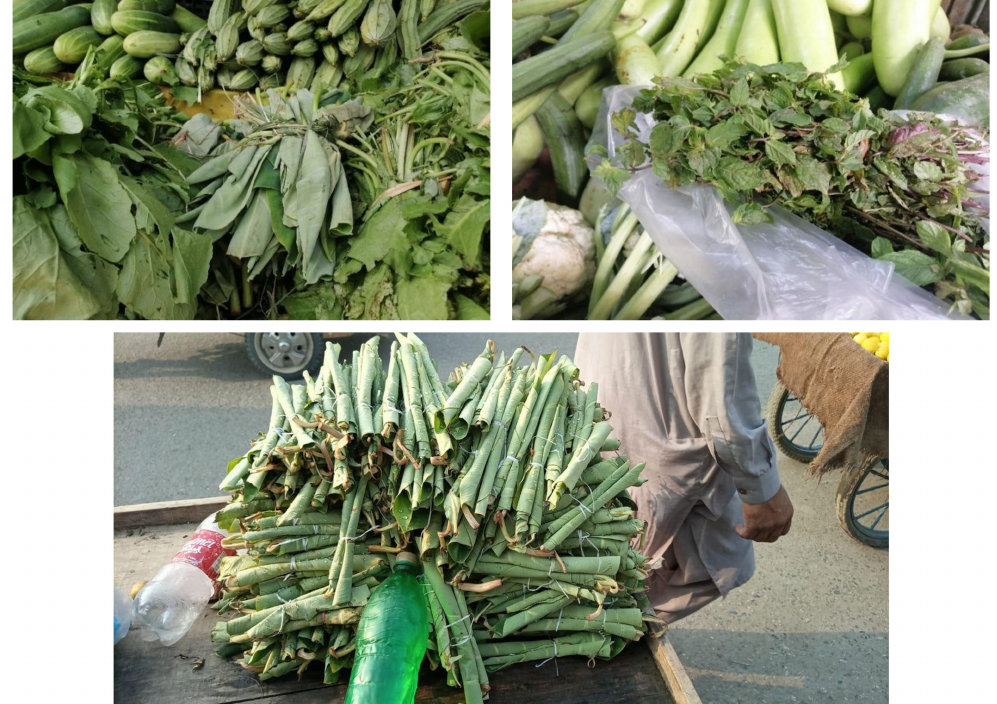
Figure 5. Colocasia and Mentha spicata for sale at the local